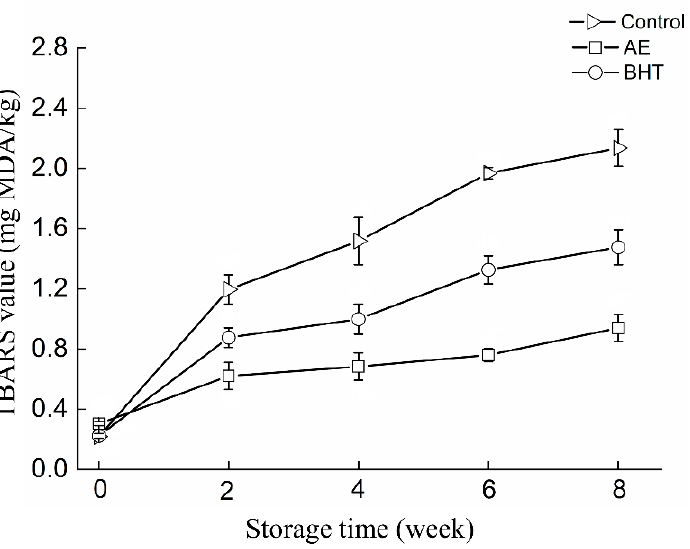
Figure 1. Changes in TBARS value of shrimp surimi products treated with AE, BHT, and control during frozen storage.